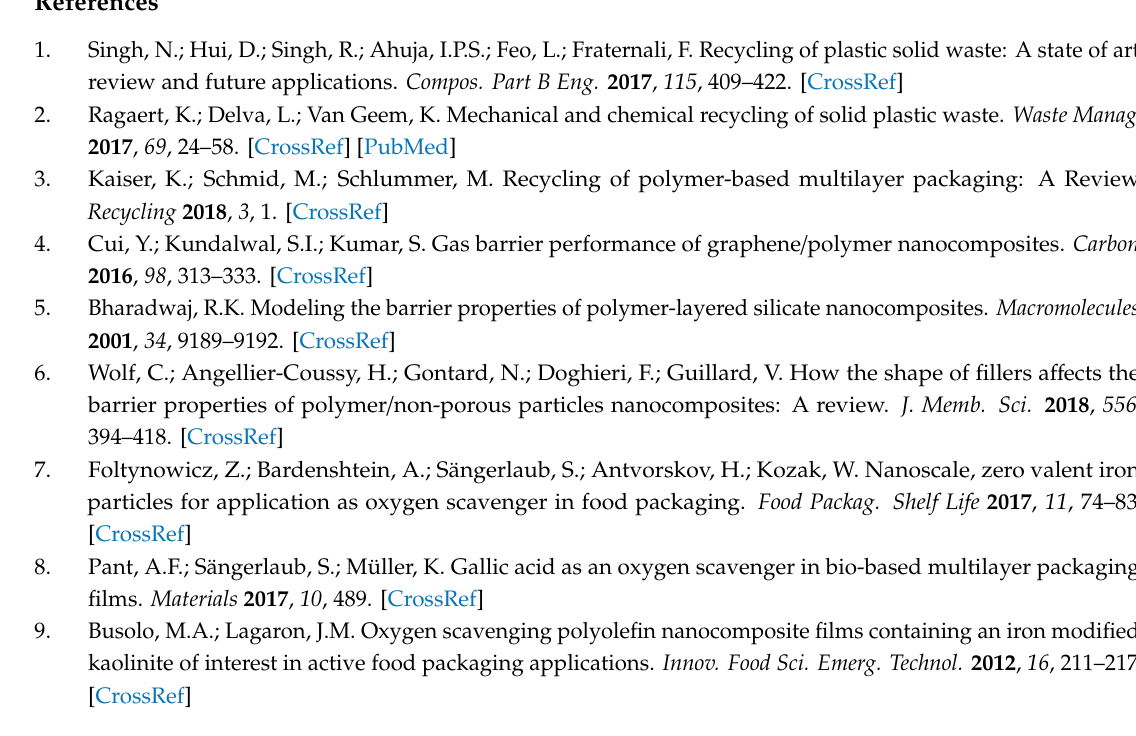
Figure A1. Schematic representation of adsorption capacity compatibility with food packaging.